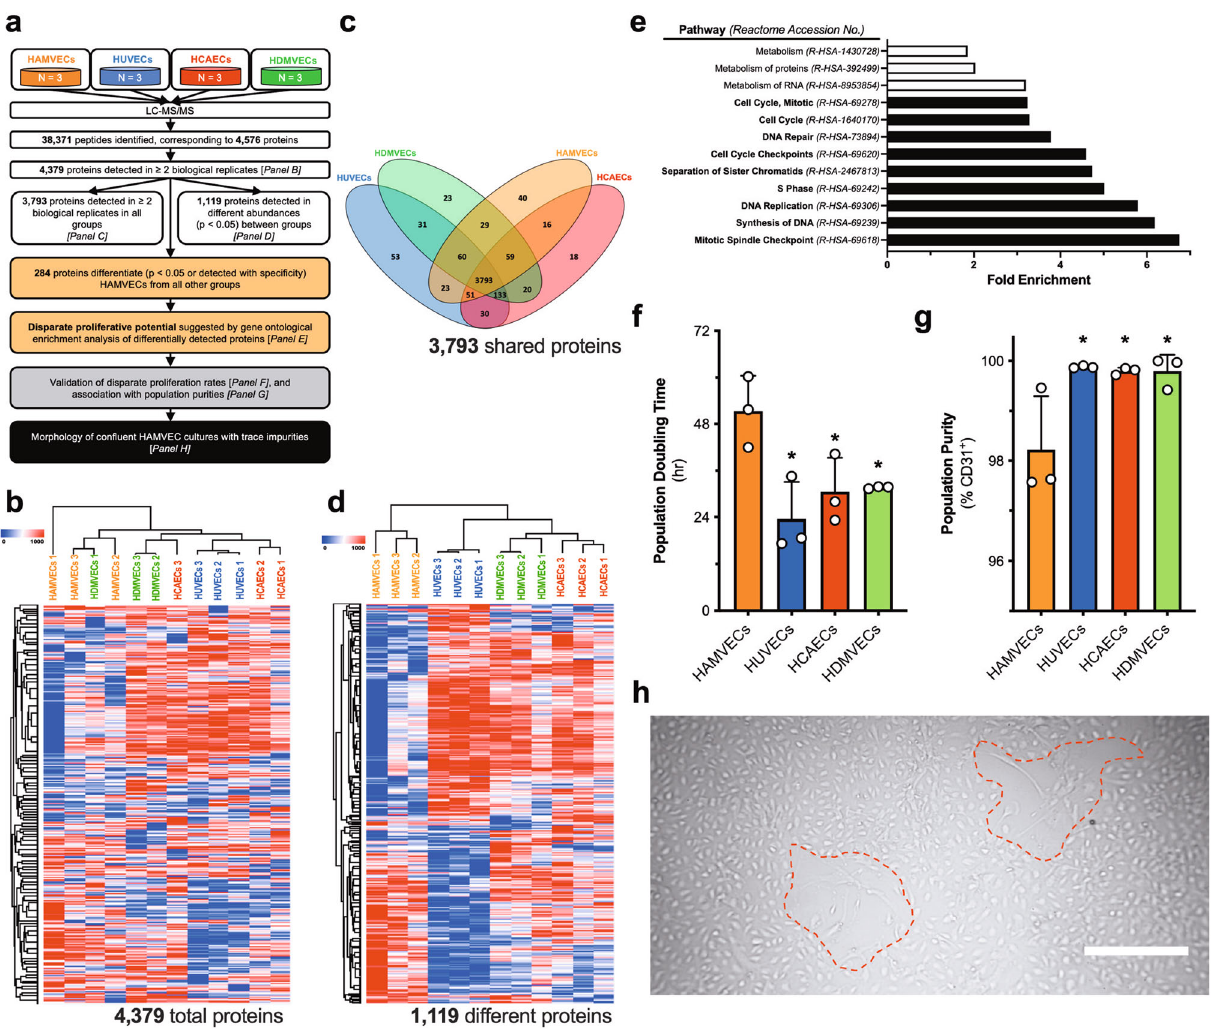
Fig. 4 Proteomic assessment of human adipose tissue-derived microvascular endothelial cells (HAMVECs) suggests that their proliferation is suppressed by adipose tissue-derived stromal/stem cells (ASCs). a Work fl ow depicting the proteomic comparison of HAMVECs with endothelial cell (EC) controls representative of the predominant endothelial specializations, namely human umbilical vein ECs (HUVECs; macrovascular, venous endothelium), human coronary artery ECs (HCAECs; macrovascular, arterial endothelium), and human dermal microvascular ECs (HDMVECs; microvascular endothelium). b Unsupervised hierarchical clustering of the proteomes of the ECs derived from four different vascular beds. c Distribution of detected proteins amongst the different ECs. d Hierarchical clustering of the proteins detected in different abundances ( p < 0.05) between EC types. e Biological pathways differentiating HAMVECs from all other types of ECs. Black bars highlight those related to proliferation; and white bars metabolism. f Population doubling times of the different ECs, determined from their exponential growth phase observed over 7 days of culture. Values represent mean ± standard deviation; and * p < 0.05 compared with HAMVECs. g Purities of the different EC cultures. Values represent mean ± standard deviation; and, * p < 0.05 compared with HAMVECs. h Representative zones of inhibition surrounding residual ASCs in primary cultures of HAMVECs that were maintained at con fl uence for over 3 weeks. Scale bar represents 500 µ m. All experiments were performed in biological triplicate, using cells derived from three different donors ( n = 3 biologically independent